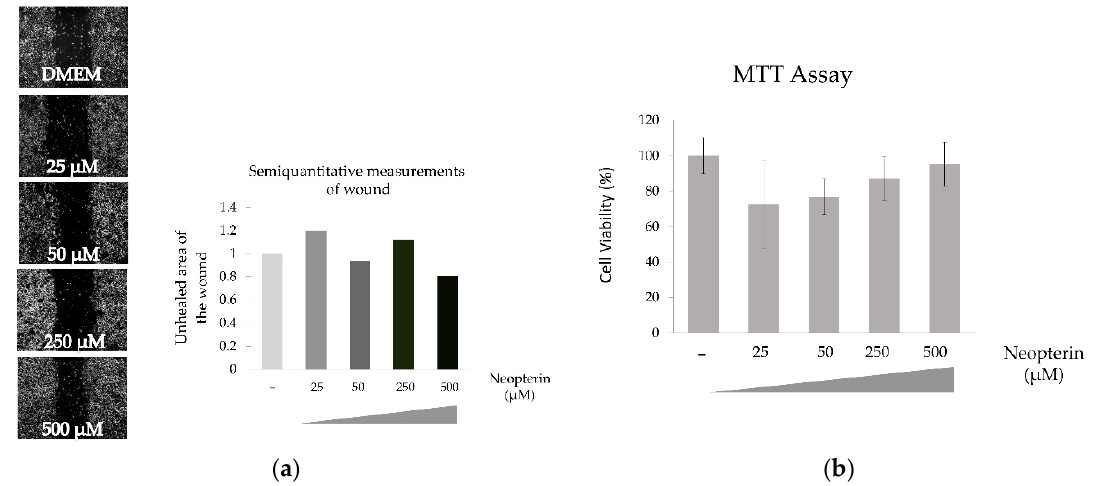
Figure 3. Effect of neopterin on wound healing ( a ) and cytotoxicity ( b ) of Hep-3B cell